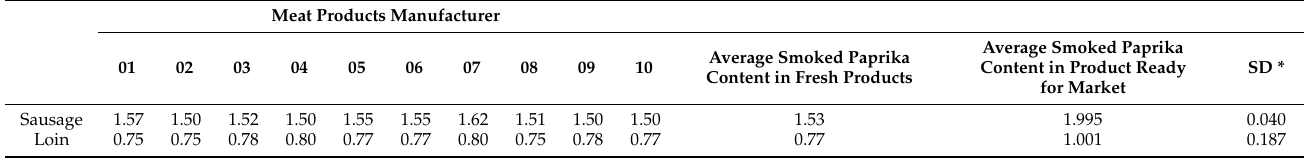
Table 1. Details on the content of smoked paprika (%) in the various processed meat products produced by 10 Extremaduran companies.